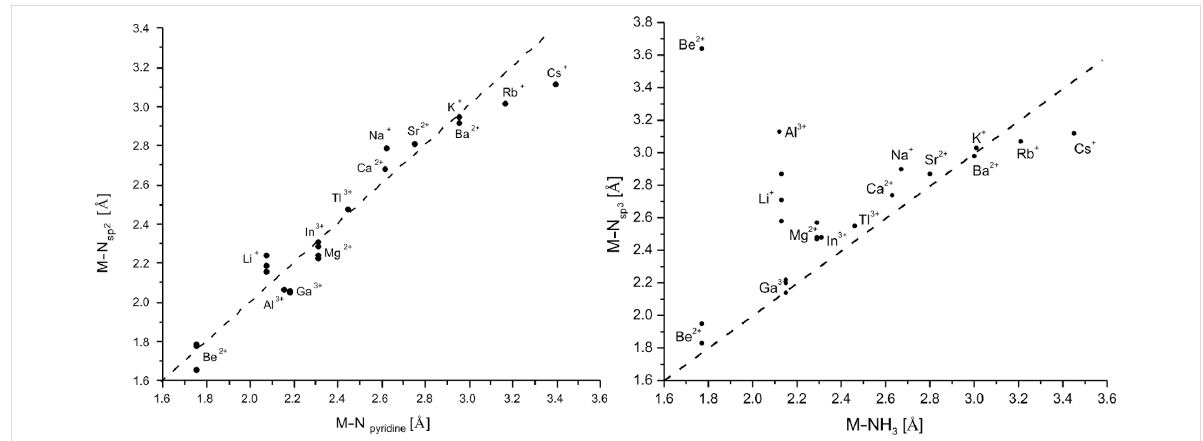
Figure 6: Comparison of the calculated (RB3LYP/LANL2DZp) M–N pyridine /M–N sp2 and M–NH 3 /M–N sp3 coordinating distances for [2.2.bpy] (dashed line: bisecting line; for the data see Table 7).